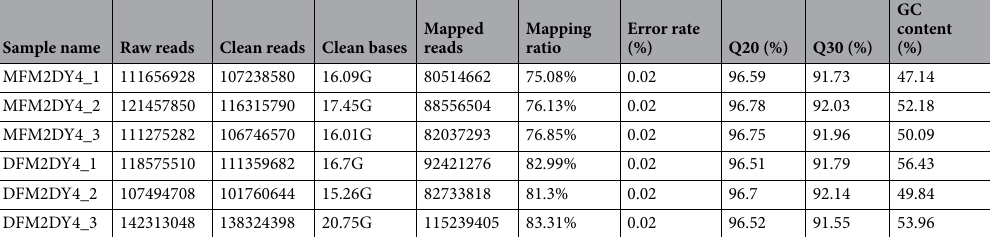
Table 1. The six library samples information.